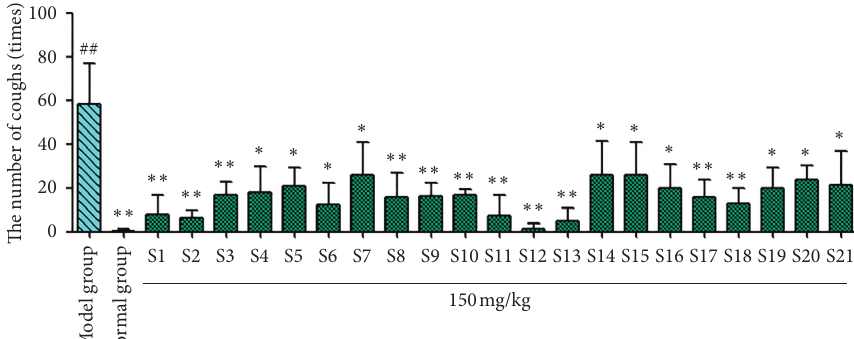
Figure 5: Results of ammonia-induced cough in Glycyrrhiza uralensis Fisch. flavonoids from 21 producing areas. The result represents mean ± S.D. Note. Compared with the normal group, ## P < 0 . 01 is a very significant difference. Compared with the model group, ∗ P < 0 . 05 was considered to be significant; ∗ ∗ P < 0 . 01, and there was a significant difference ( n �